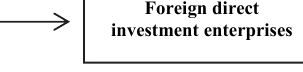
Fig. 2. Model estimation